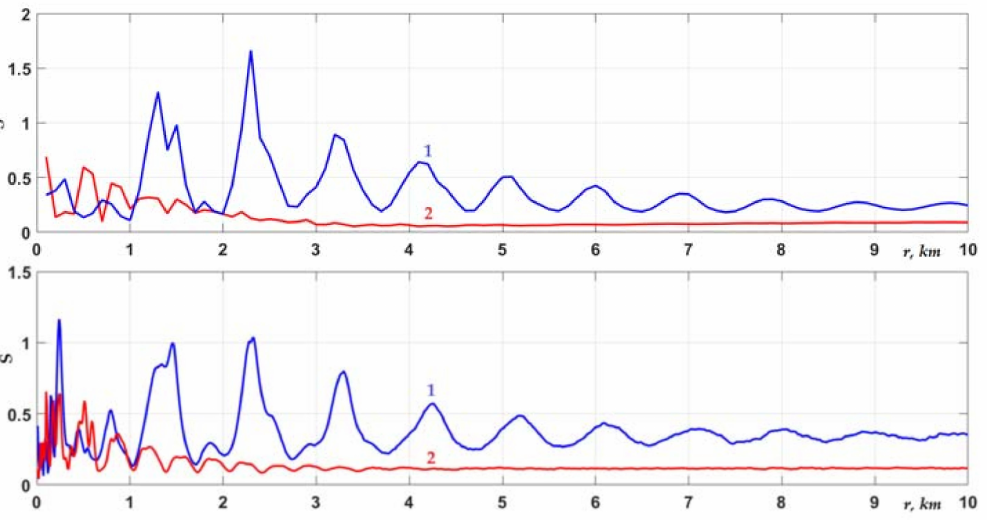
Figure 11. Behavior of the scintillation index of a signal of 250 Hz in a waveguide with bathymetry fluctuations δ h . (cid:104) c 1 (cid:105) = 1500 m/s, δ c 1 = 0. Top graph corresponds to L h = 1 km; curves: 1 is OW solution, z = z 0 = 36 m, 2 is for z = z 0 = 24 m. Lower graph corresponds to L h = 100 m; curves: 1 is OW solution, z = z 0 = 36 m, 2 is for z = z 0 = 24